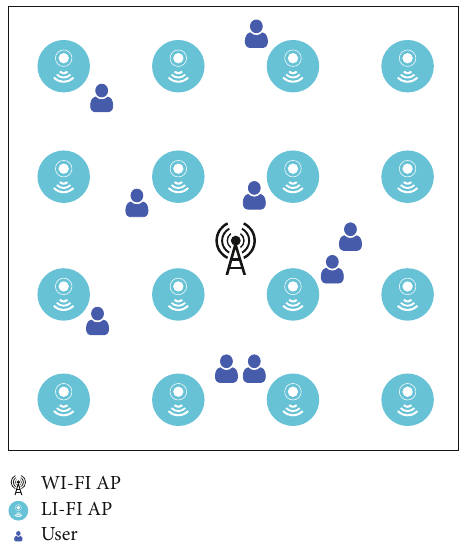
Figure 1: Indoor LiFi/WiFi hybrid network model